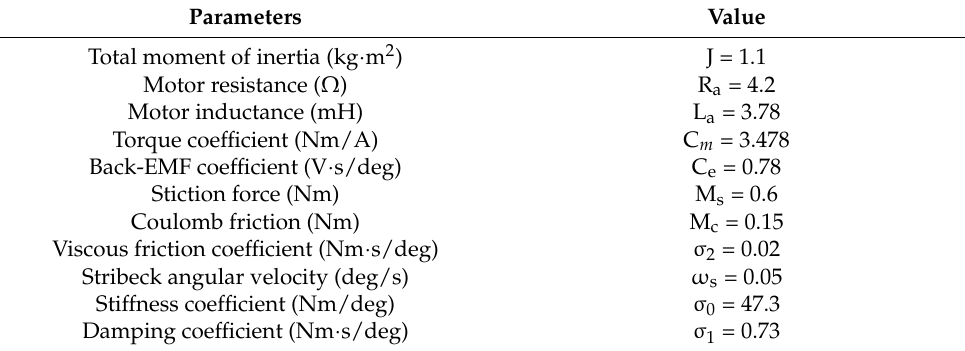
Table 1. System and LuGre model parameters.